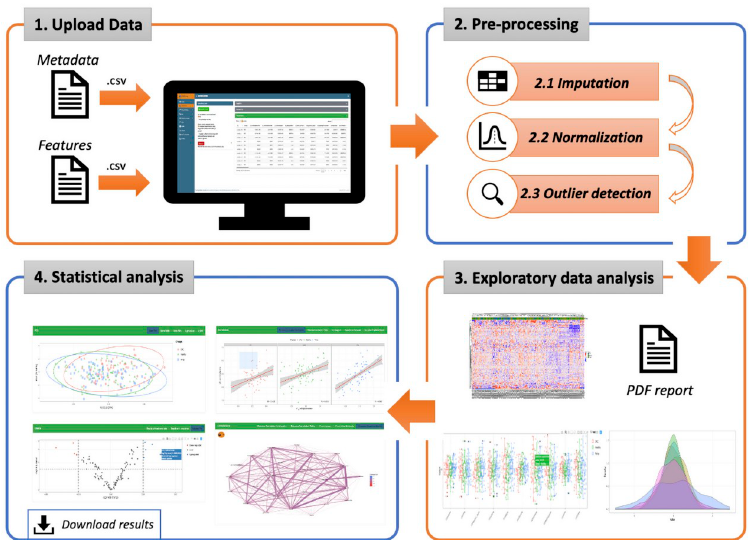
Fig 1. POMAShiny’s workflow. The workflow is divided into four well-separated panels. Both target and features files are required as an input. Once these files are uploaded, the data are preprocessed and prepared for display in the exploratory data analysis panel (EDA). Finally, after the preprocessing and EDA panels, several statistical methods and options are provided in the statistical analysis panel, where users can analyse the data and download the results in both plot and table formats ( icons made by Freepik from